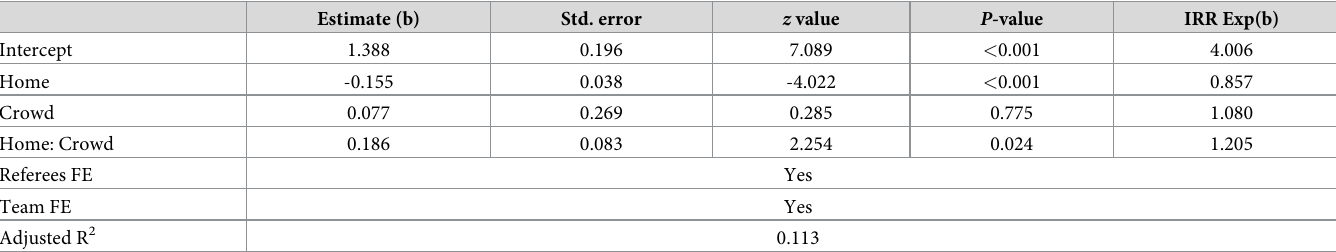
Table 2. Estimated regression parameters for NHL playoffs Poisson GLMM ( n =